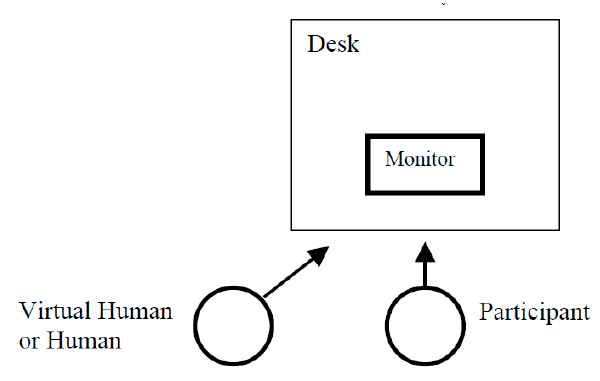
Figure 3. The layout of the experiment.